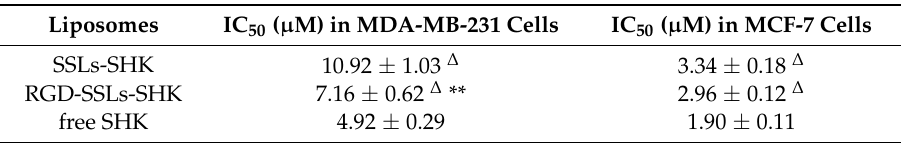
Figure 6. In vitro cytotoxicity effects of different Shikonin (SHK) formulations on: MDA-MB-231 cells ( A ); and MCF-7 cells by MTT assay ( B ). Both cells were treated with SSLs-SHK, RGD-SSLs-SHK, and free SHK at various concentrations of SHK for 24 h. Table 2. The half-maximal inhibitory concentration (IC 50 ) of different SHK formulations on tumor cells (mean ± SD, n = 3).